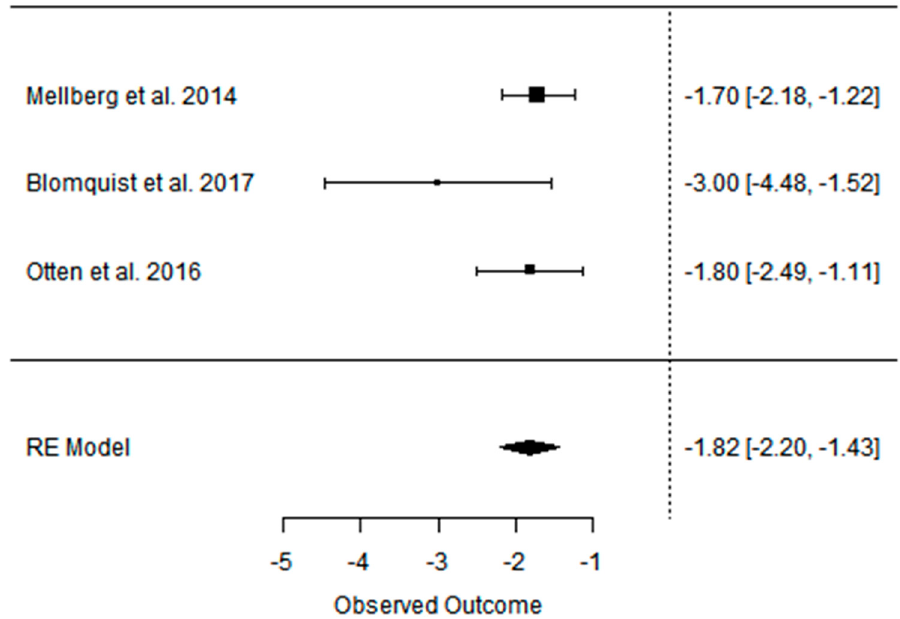
Figure A13. Forest plot of the effect of a CD on BMI in the long term (weighted mean difference).